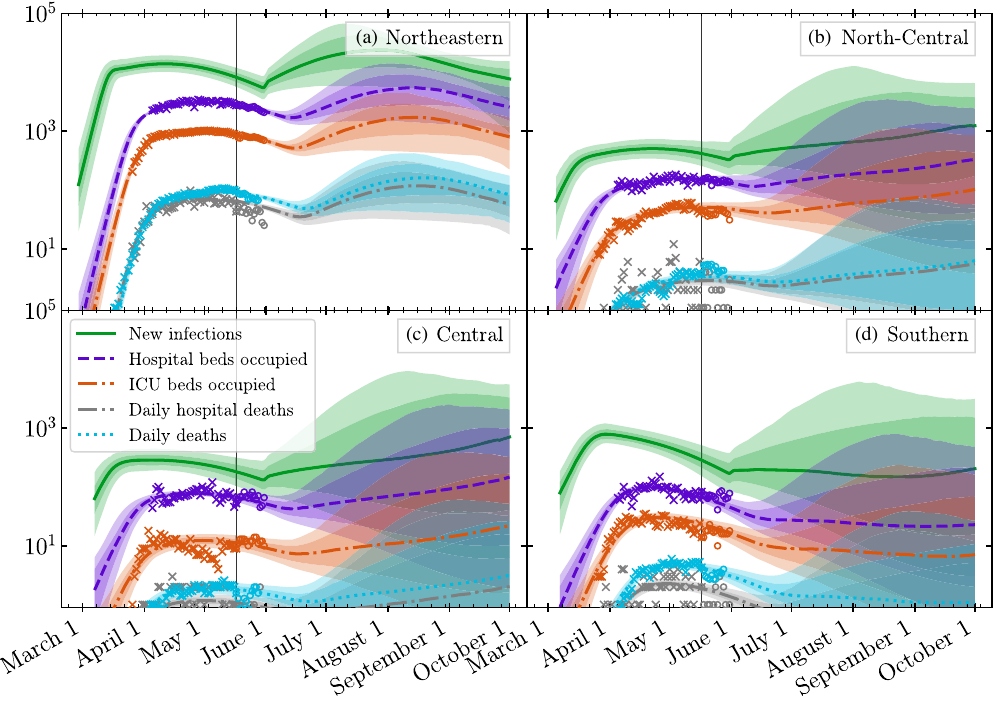
FIG. 9. Fits and predictions of our model under the a partial release of the stay-at-home order on June 1, 2020 to a mitigation factor M ð t Þ ¼ M ð t Þ þ 0 . 3 × ( 1 − M ð t Þ ) . The panels and plots denote the same regions and data sources as those in Fig. 1 1